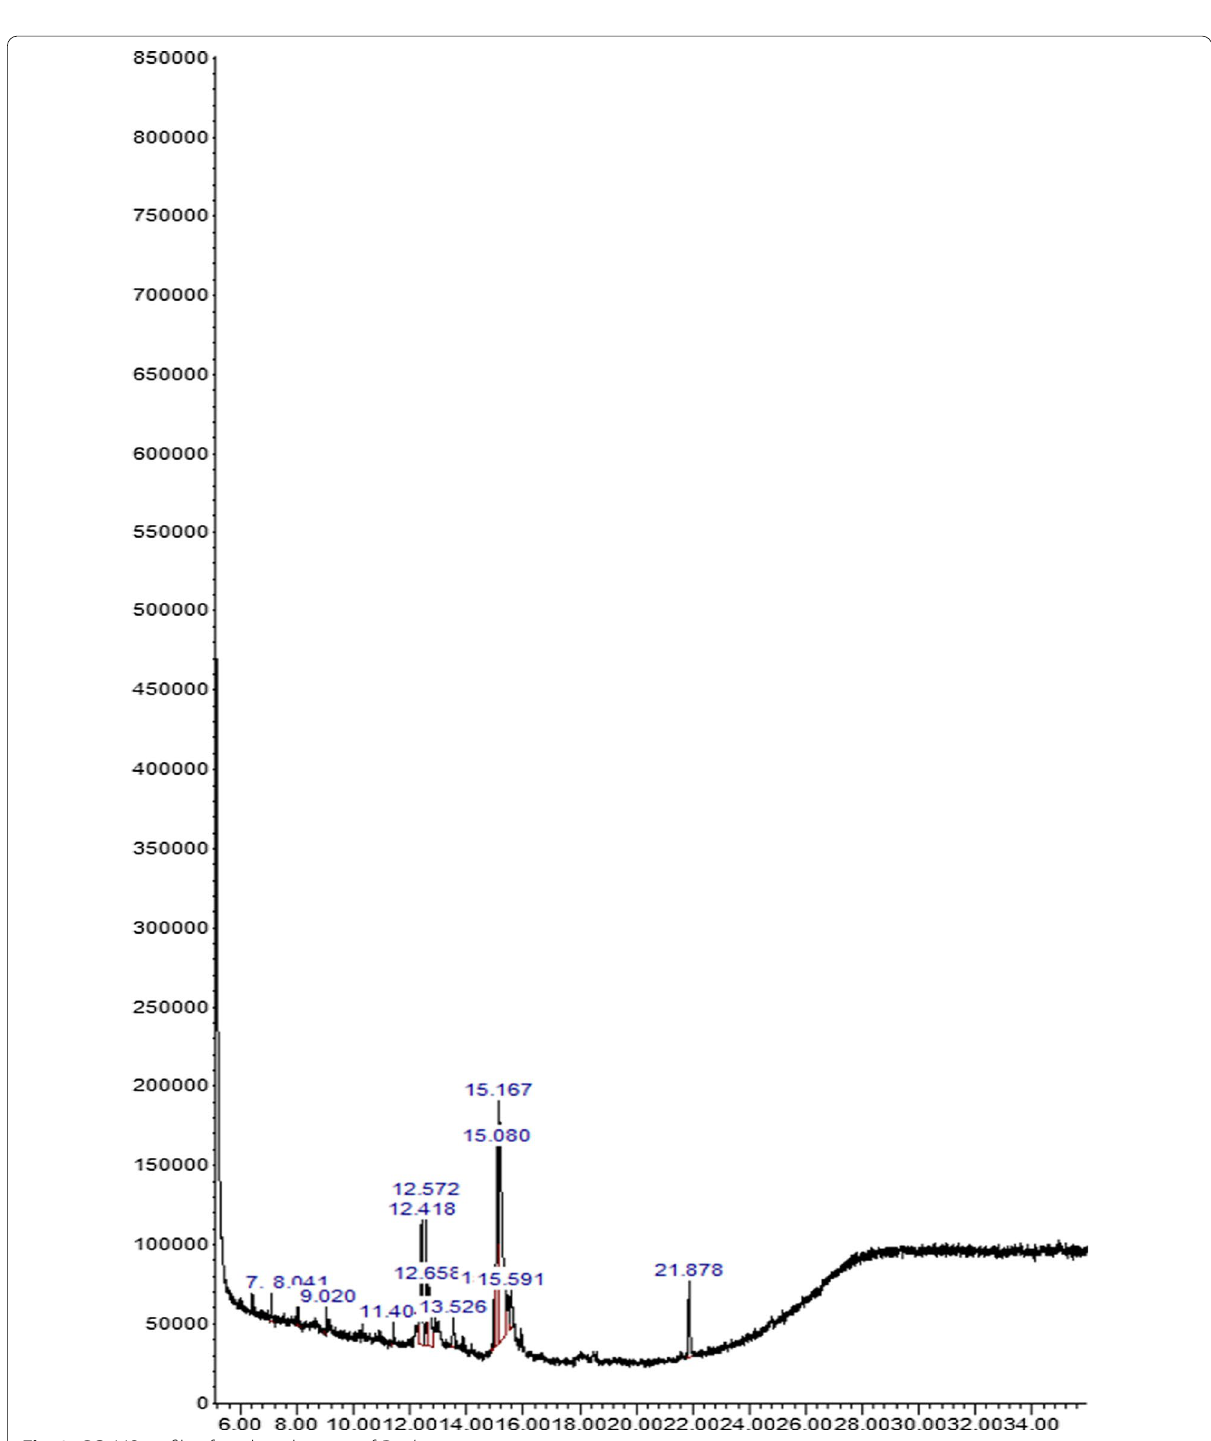
Fig. 2 GC–MS profile of methanol extract of D.arborescens